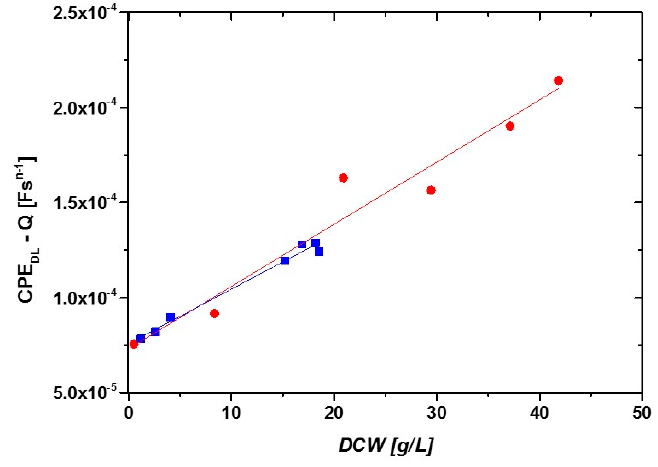
Figure 6. Correlation between DCW and impedance signal (CPE dl -Q) measured in online mode during two fed batch cultivations with different feeding strategies.